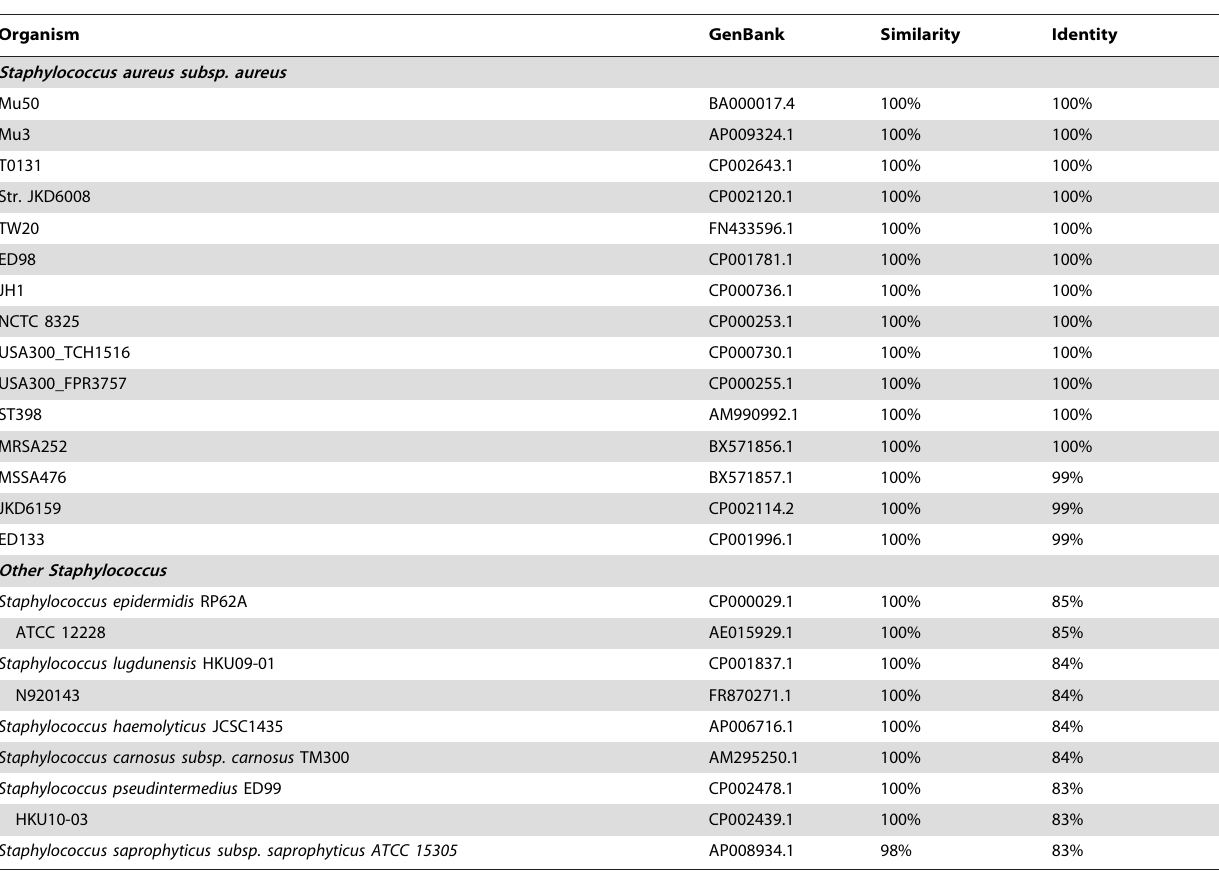
Table 1. Homologies of gene rpoD among Staphylococcus species.